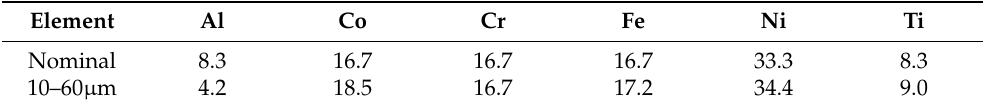
Table 2. The compositions of the nominal elements and as-atomized Al 0.5 CoCrFeNi 2 Ti 0.5 powder.